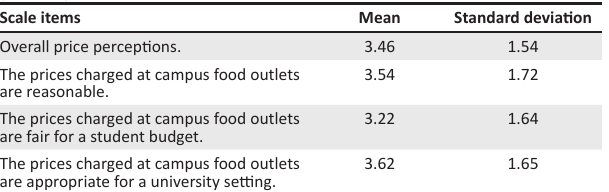
TABLE 5: Mean and standard deviation for items in the Price Perception Scale ( N = 200).